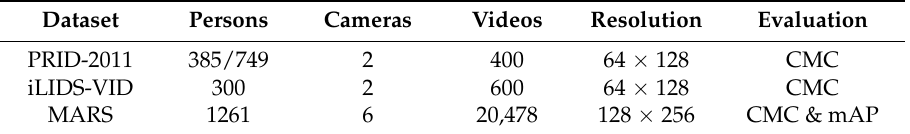
Table 2. Detailed information of the experimental